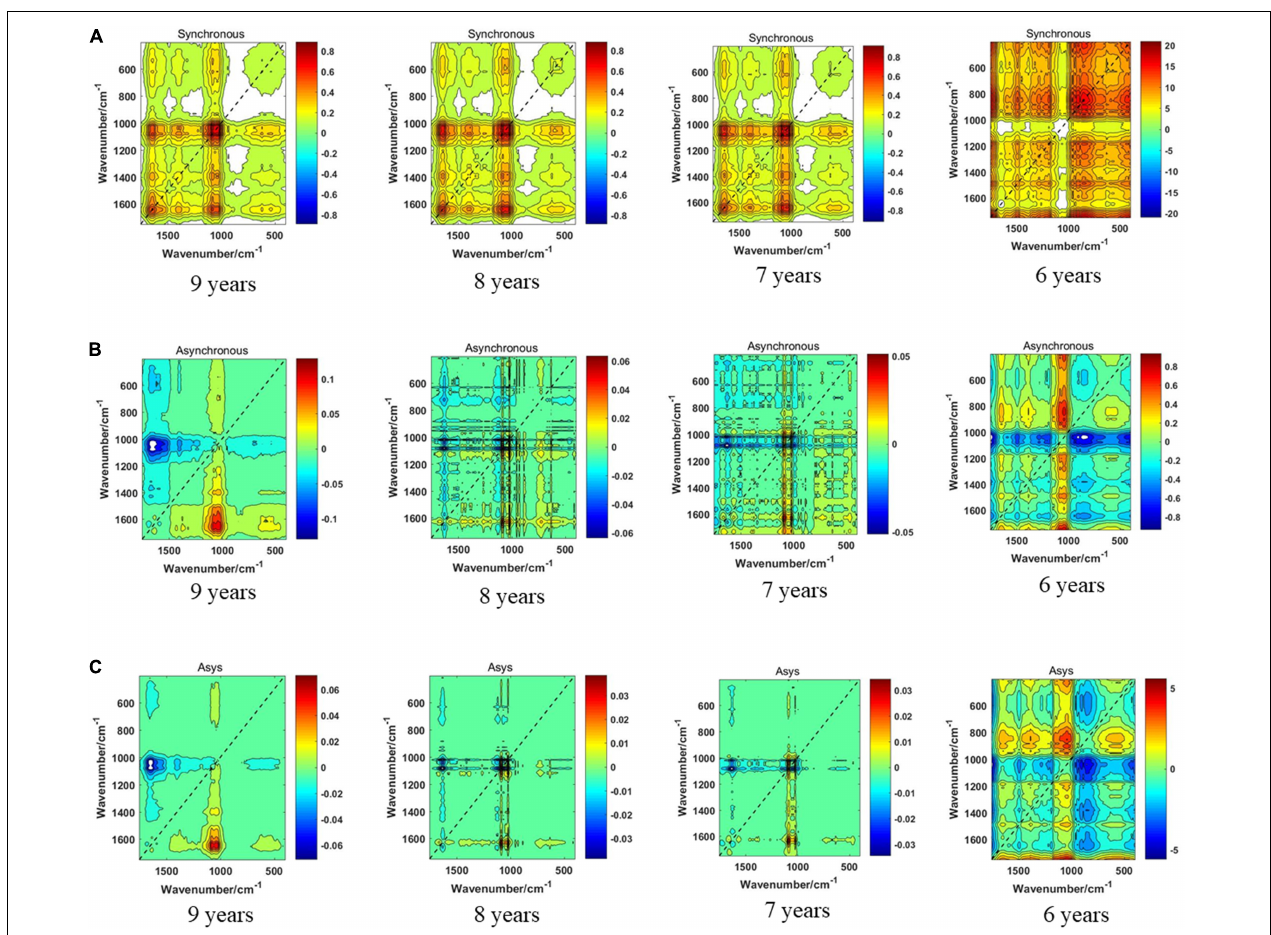
FIGURE 5 | (A) The synchronous 2DCOS spectra of the 1,750–400-cm − 1 band. (B) The asynchronous 2DCOS of the 1,750–400-cm − 1 band. (C) The i2DCOS spectra of the 1,750–400-cm − 1